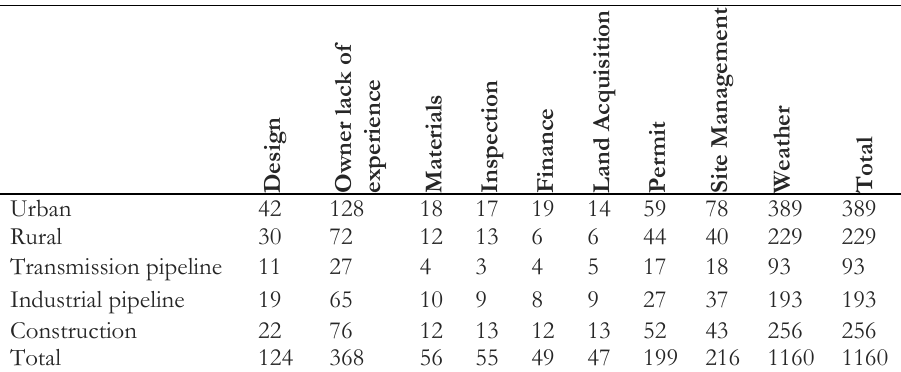
Table 4. Frequency of delay